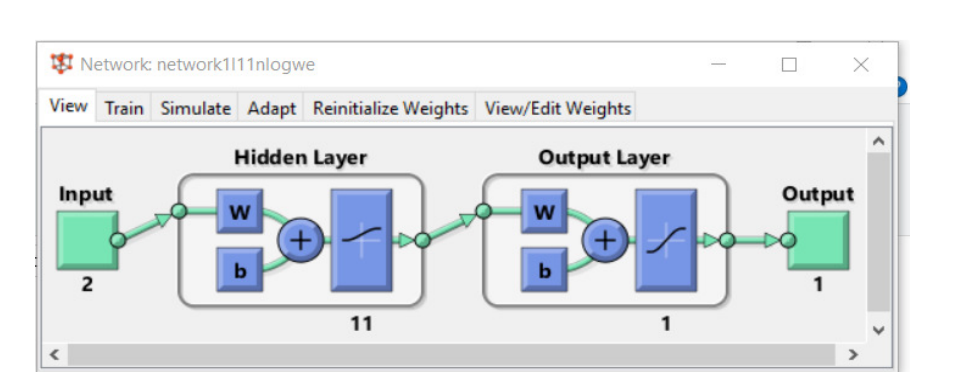
Fig. 6. Neural Network Structure.